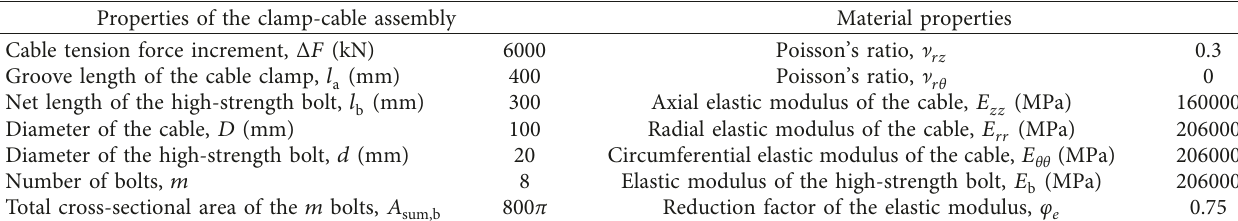
Table 1: Default properties of the clamp-cable